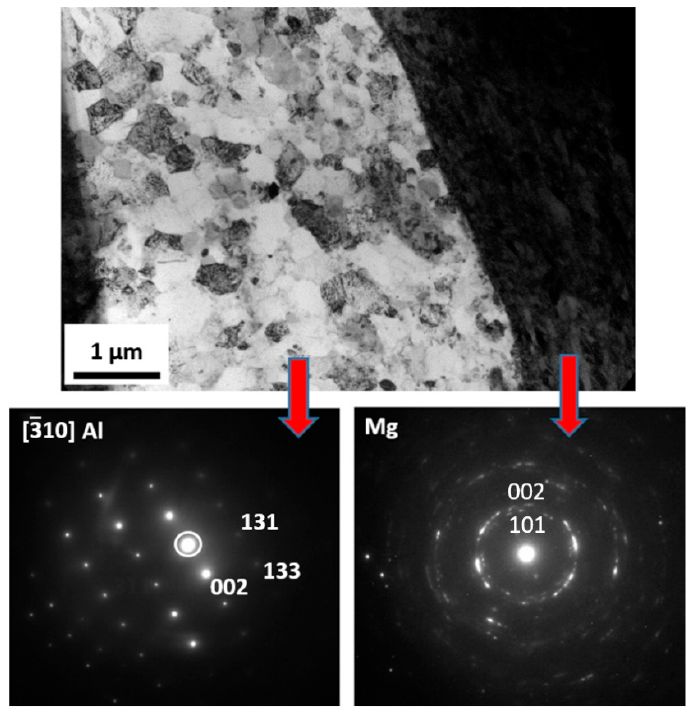
Figure 12. TEM image of AZ31/AA1050 joint microstructure in as-welded state with selected area diffraction patterns (SAED). TEM lamella position in Figure 11A.